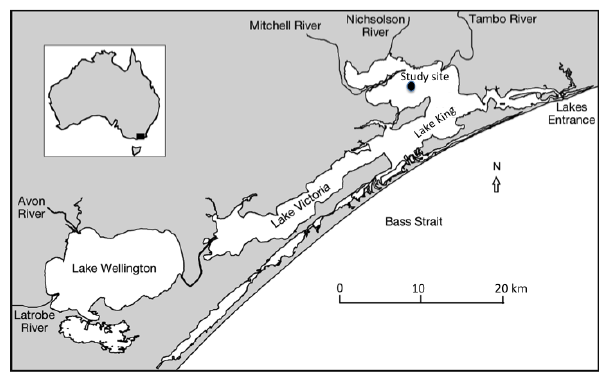
Figure 1. The Gippsland Lakes, south-eastern Australia. The study site in northern Lake King is marked with the solid circle (37.875620 ◦ S, 147.757280 ◦